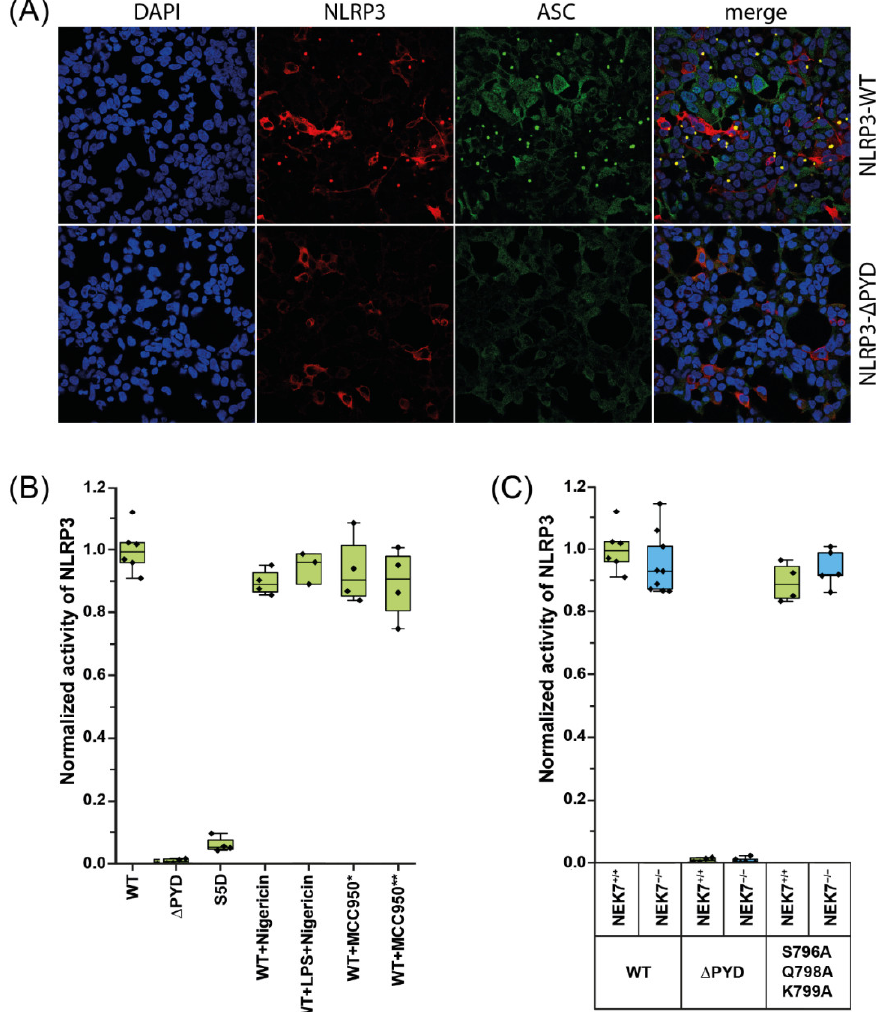
Figure 1. Quantification of ASC speck containing HEK293-ASC cells after transfection of wild-type or mutant NLRP3. ( A ) Representative confocal fluorescence images of HEK293-ASC cells transfected with wild-type (NLRP3-WT) or PYD-deleted (NLRP3 ∆ PYD) NLRP3-Flag. Primary antibodies against M2-Flag and Myc were used to detect NLRP3-Flag (red) and ASC-Myc (green). Nuclei were stained with DAPI (blue); ( B ) Quantification of HEK293-ASC cells containing ASC specks after transfection of wild-type or mutant NLRP3 in the presence or absence of nigericin, LPS, and MCC950. MCC950 was added during and after ASC expression induction (*) or during and after NLRP3 transfection (**). Box plots represent the ratio of speck-positive cells to the total of transfected cells. They show the interquartile range (IQR) and the median. Each dot represents one experiment. Whiskers include experiments within 1.5 × IQR. For each experiment, six images were counted with at least one hundred cells each; ( C ) Quantification of wild-type or NEK7-knockout HEK293-ASC cells containing ASC specks after transfection of wild-type or mutant NLRP3. Box plots represent the ratio of speck- positive cells to the total of transfected cells. They show the IQR and the median. Each dot represents one experiment. Whiskers include experiments within 1.5 × IQR. For each experiment, six images were counted with at least one hundred cells